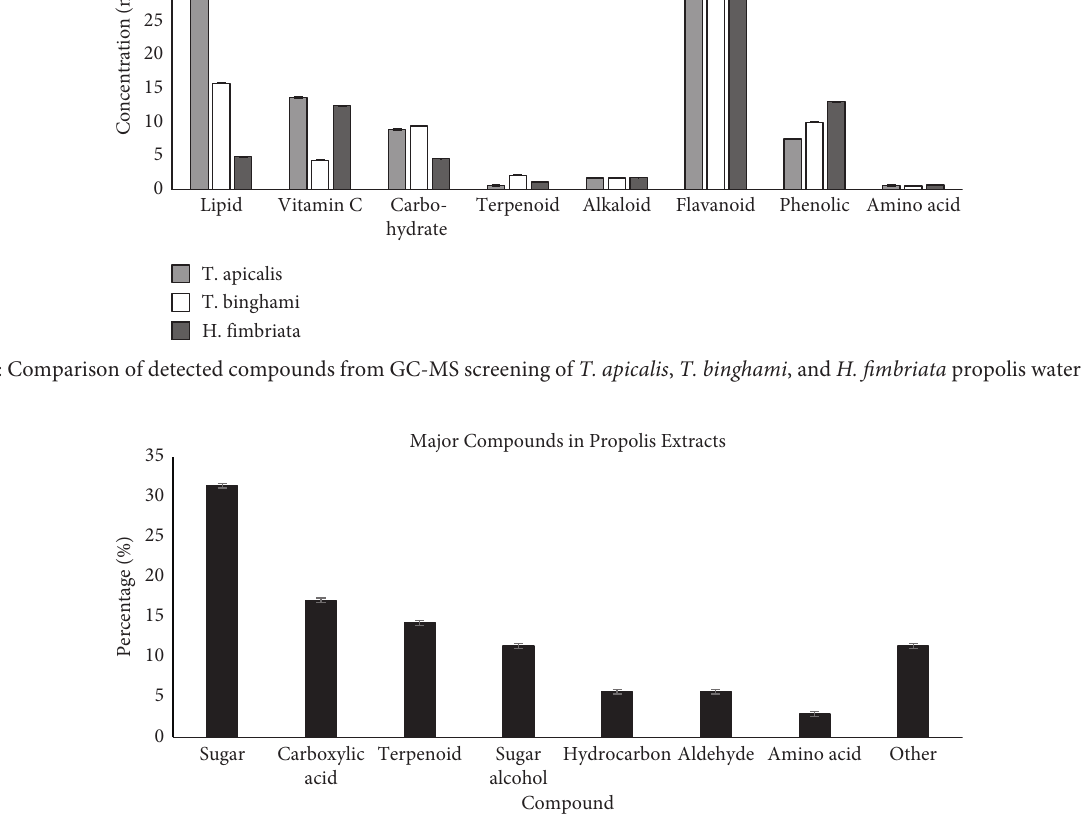
Figure 5: Major chemical compounds detected in GC-MS analysis of T. apicalis , T. binghami , and H. fimbriata propolis water extracts.